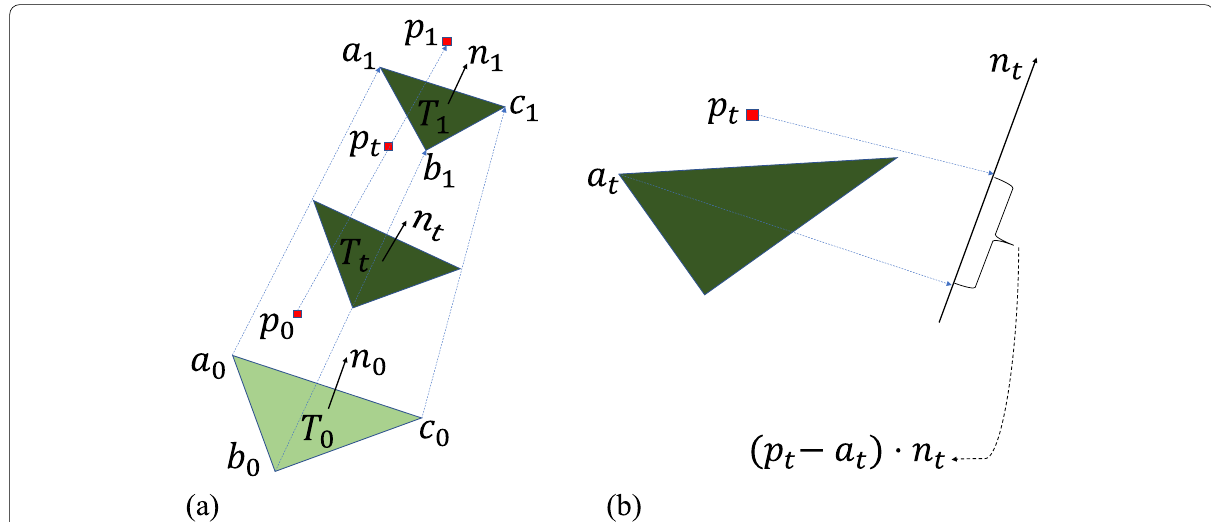
Fig. 3 Vertex‑face test: To perform a vertex‑face test between a deforming triangle (defined by a 0 , b 0 , and c 0 at t a moving vertex (defined by p 0 at t distance along the normal vector of the triangle is equal to zero, that is, ( p t